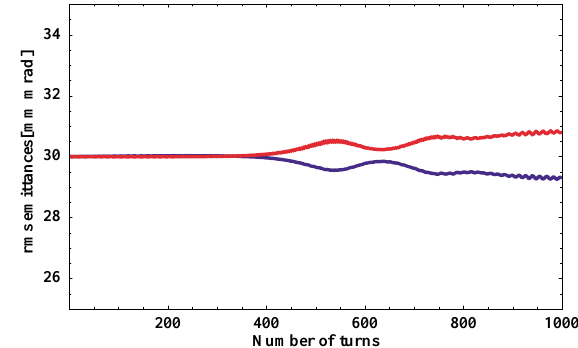
FIG. 6. (Color) Y - P y phase-space plot at 375 turns for (cid:2) (cid:1) (cid:1) 5.82, 5.79 (cid:2) . (cid:1) n x , n y